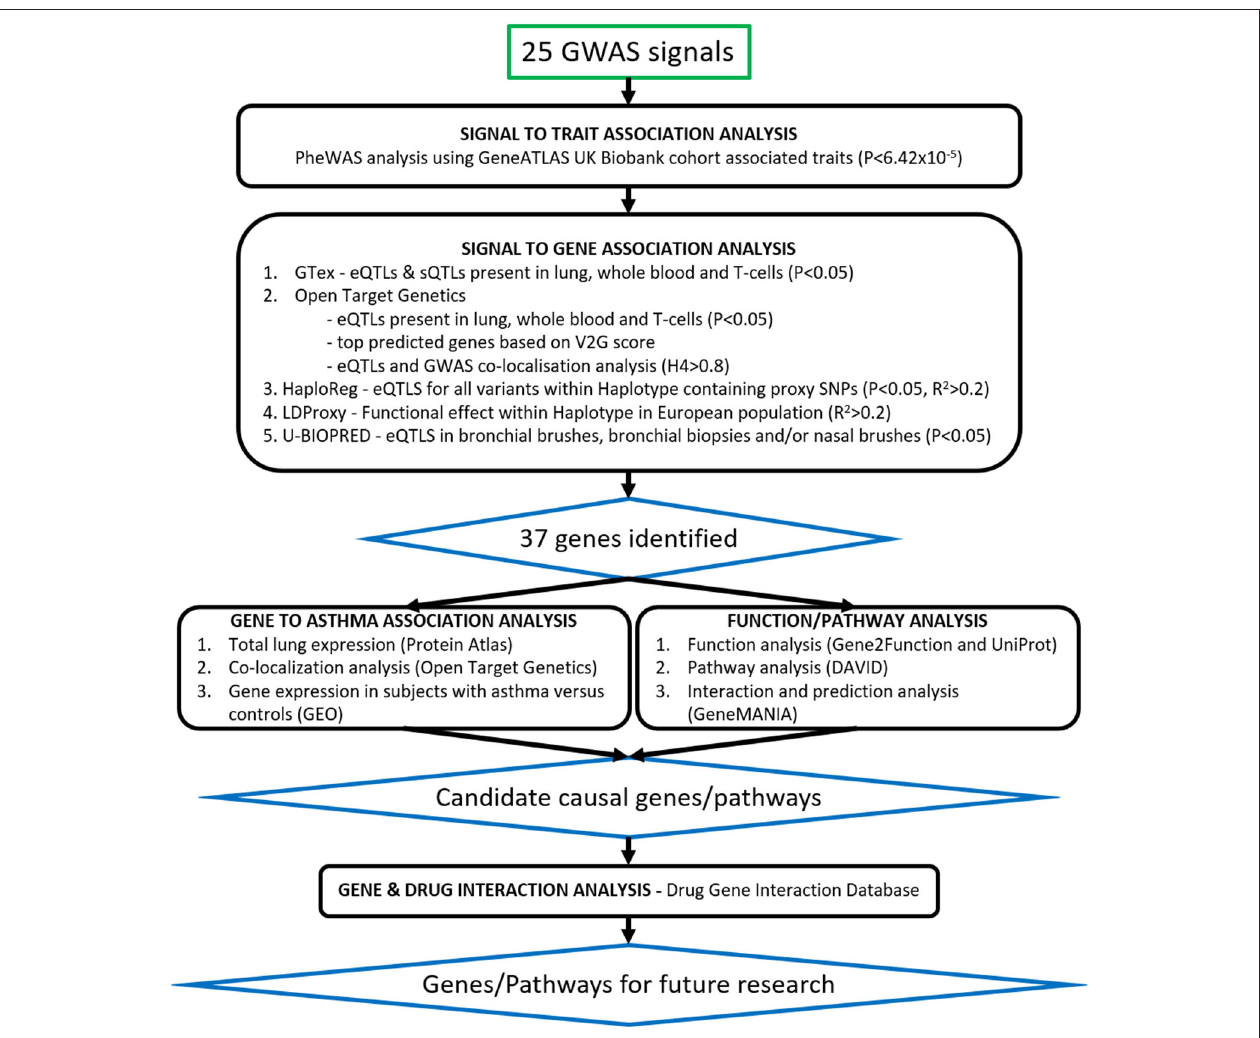
FIGURE 1 | Translational analysis pipeline. Twenty-five signals from the Moderate to Severe Asthma GWAS were taken through signal to trait and signal to gene association analyses. Signals were searched for in publicly available databases such as GeneATLAS, PheWAS, Open Target Genetics, GTex, HaploReg and LDLink as well as our U-BIOPRED (UB) datasets of Bronchial Biopsies, Bronchial Brushes, and Nasal Brushes. Gene association was scored as per Table 3 and 37 genes were identified. Candidate causal genes were then searched for in gene expression datasets from subjects with asthma vs. controls and single-cell-RNA lung tissue datasets. Asthma related pathways and interactions between genes were identified using the DAVID Functional Annotation Tool and GeneMANIA prediction server and drug gene interactions were identified using the Drug Gene Interaction